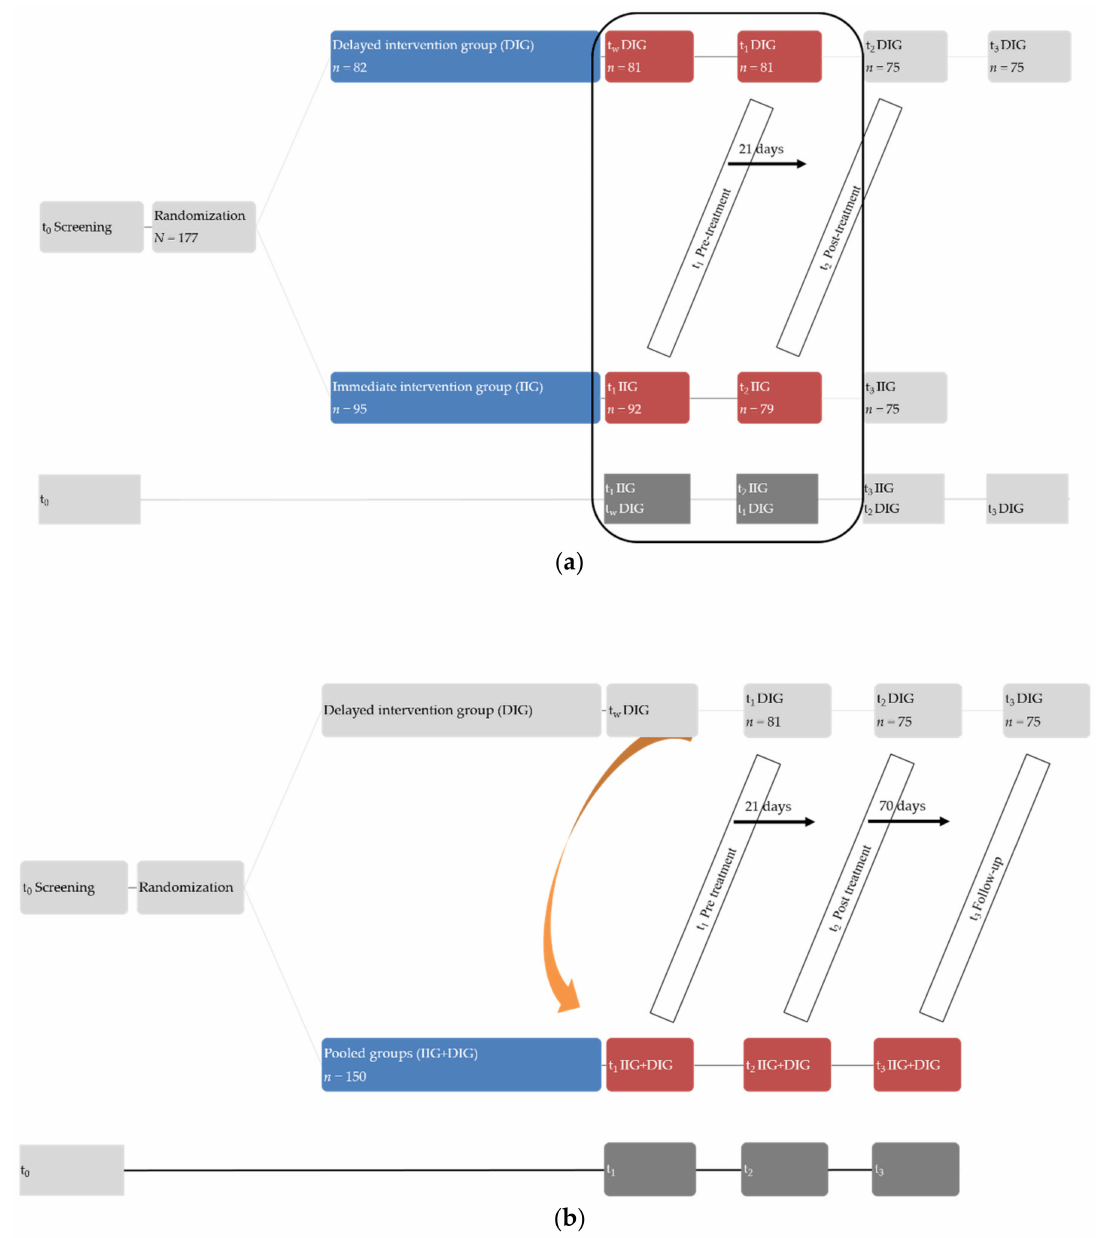
Figure 2. Between-subject analyses ( a ) and within-subject analyses ( b ), investigating treatment- related effects. Note: the IIG and DIG did not differ on any of the investigated outcome measures at pre-treatment (t 1 IIG; t 1